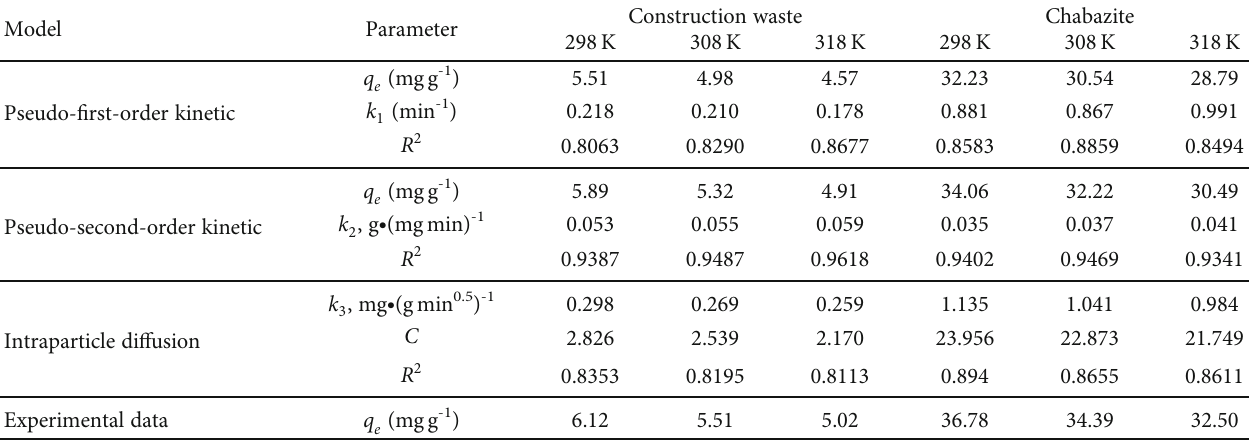
Table 5: Parameters of dynamic models of MB on construction waste and chabazite at di ff erent temperatures. Model